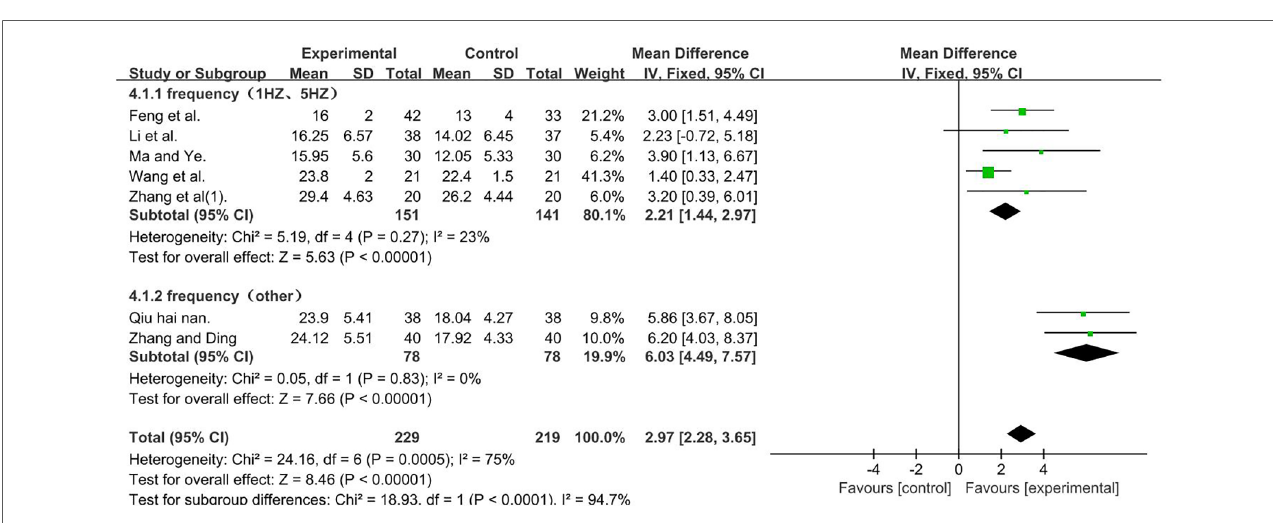
FIGURE 7 Forest plot showing MD (with 95% CI) for GMFM-D of the included studies comparing the experimental and control groups. Note: For the subgroup with frequencies of 1 and 5 HZ, P =0.27 and I 2 =23%. The fi xed-effect model [MD=2.21, 95% CI (1.44,2.97); P <0.001]. For the subgroup with the frequency of